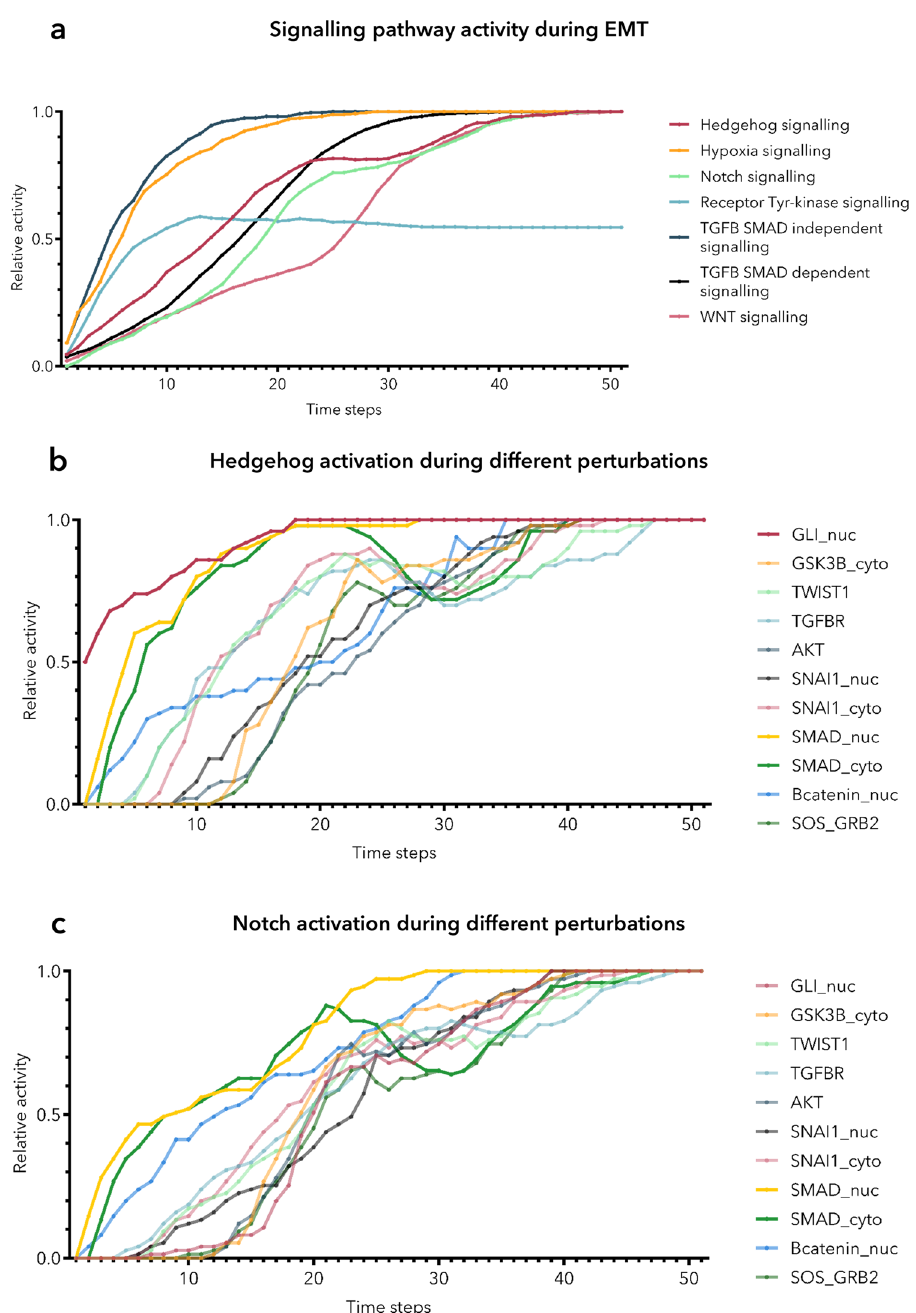
Fig. 5 Signalling pathway activities during EMT. a We plotted the activity of the main pathways during EMT on this panel. There are 11 single node perturbations that led to EMT, here we show the average of the pathway activities that can be observed during these 11 perturbations. We can see that there was a difference in the kinetics of the activation of different pathways. Importantly, we could still observe that TGFB activation is accompanied by the activation of the Hedgehog and Wnt pathways as captured by the original EMT model 23 . b On this panel we show the activation of the Hedgehog signalling pathway for different perturbations. Each line symbolizes one speci fi c perturbation which led to EMT and thus the activation of the Hedgehog pathway. We note here that the perturbation of the TGFB pathway member SMAD proteins (yellow and green) resulted in a quicker and more robust activation of the Hedgehog pathway. The most robust activation could be observed when we activated the nuclear pool of GLI proteins, with the perturbation of the GLI_nuc node (brown). c Here, we represent the activation of the Notch signalling pathway for different perturbations similarly as we showed it in the case of Hedgehog signalling on panel b. Here the activation of SMAD proteins resulted in a quick and robust activation of the Notch pathway which underlines the crosstalk between these highlighted in the case of the original publication 23,48 (Fig. 5a), but also captured the activation of other important pathways (RTK, Notch and Hypoxia signalling). Moreover, the activatory perturba- This signalling pathway-level analysis con fi rmed that WNT and tion of SMAD proteins resulted in a quicker activation of the Hedgehog pathways are jointly activated during EMT as it was